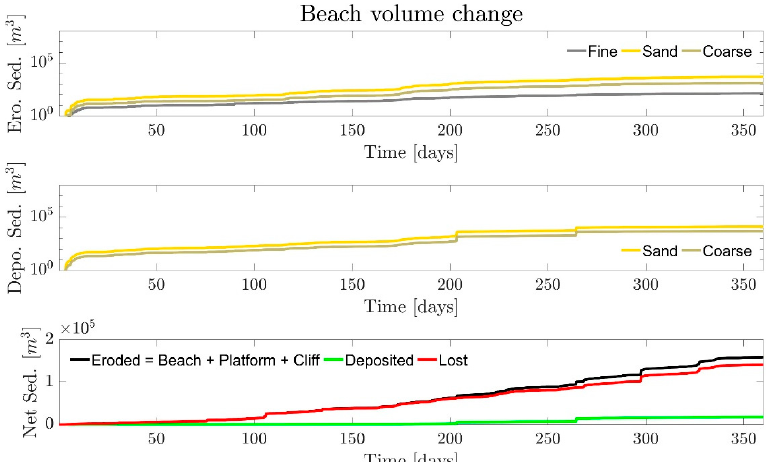
Figure 15. Simulated beach volume accumulated changes. From top to bottom; eroded, deposited and net total sediment net total sediment volume.